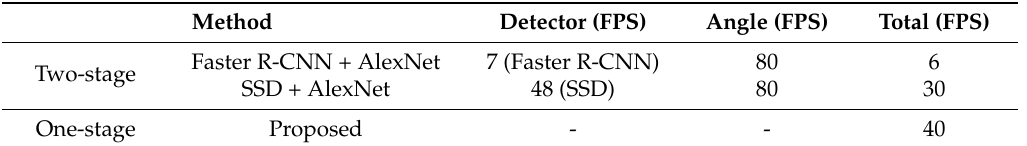
Table 4. Speed comparison between the two-stage and one-stage